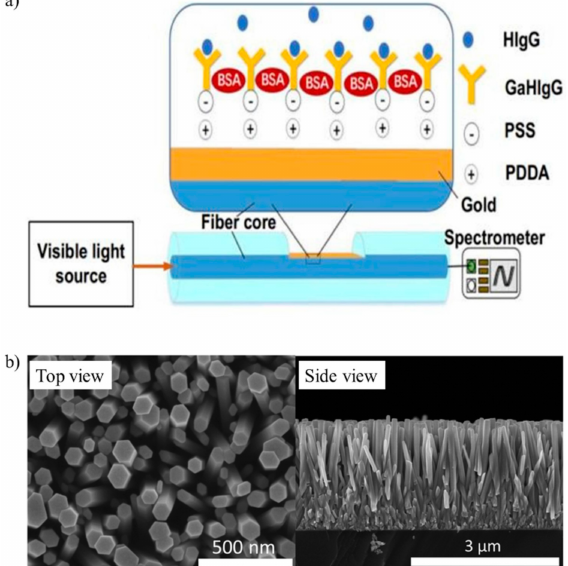
Figure 2. ( a ) Optical D-type fiber immunosensor functionalized with poly dimethyl diallyl ammonium chloride (PDDA) and poly(sodium-p-styrenesulfonate) (PSS) to immobilize goat anti-human IgG (GaHIgG) for detecting human IgG (HIgG) (adapted with permission from [79], Copyright Elsevier 2020). ( b ) Top and side SEM images of SiO 2 / ZnO nanowires (adapted from [88] with permission from The Royal Society of